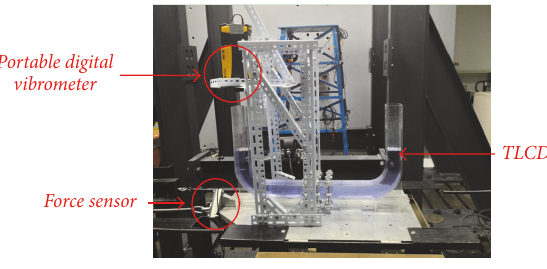
Figure 7: Testing device for